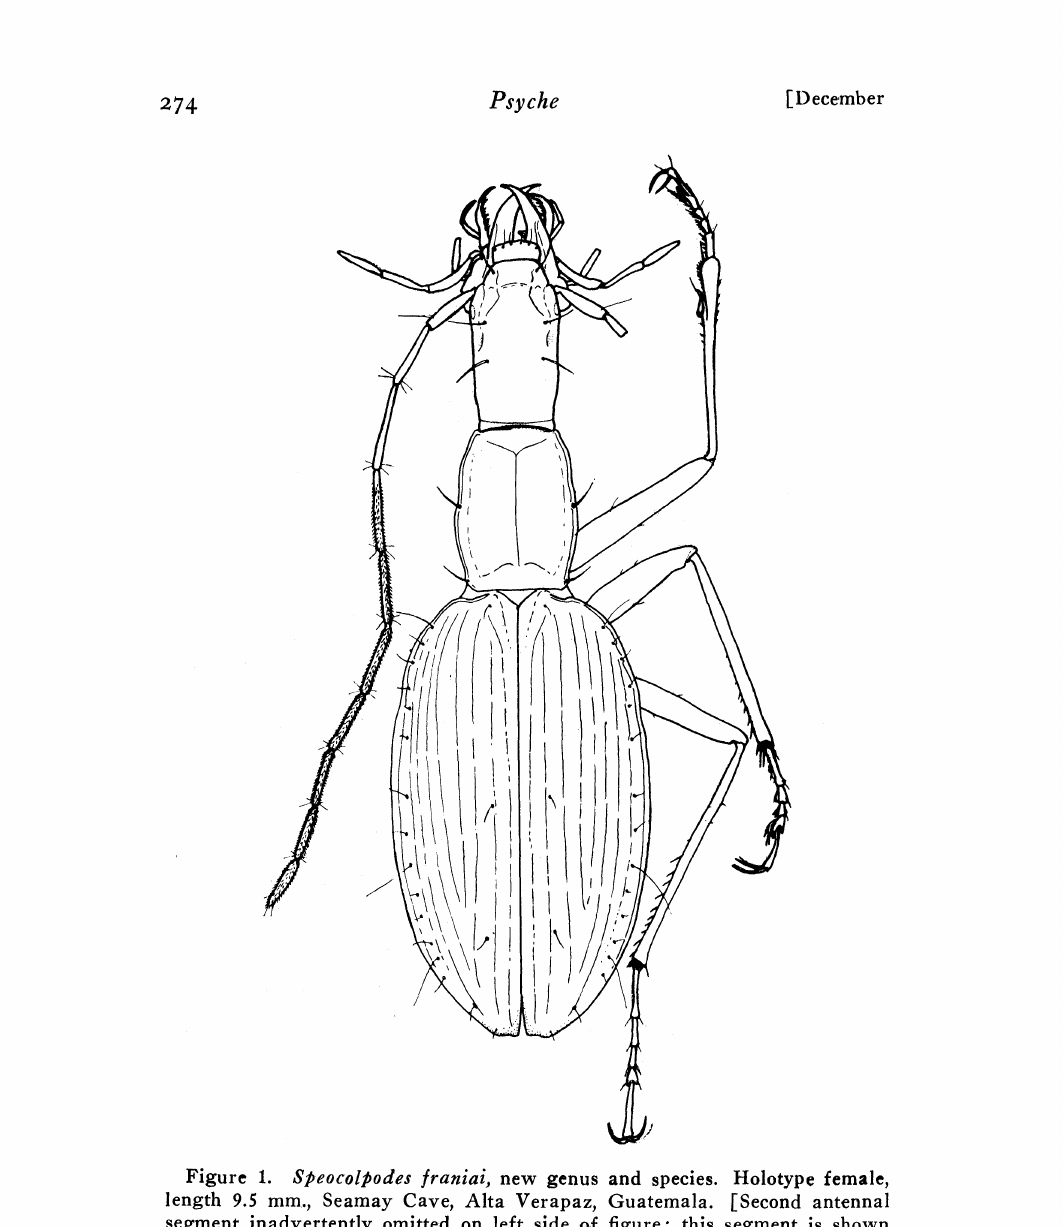
Figure 1. Seocolodes franiai, new genus and species. Holotype female, length 9.5 mm., Seamay Cave, Alta Verapaz, Guatemala. [Second antennal segment inadvertently omitted on left side o.f figure; this segment is shown correctly on right